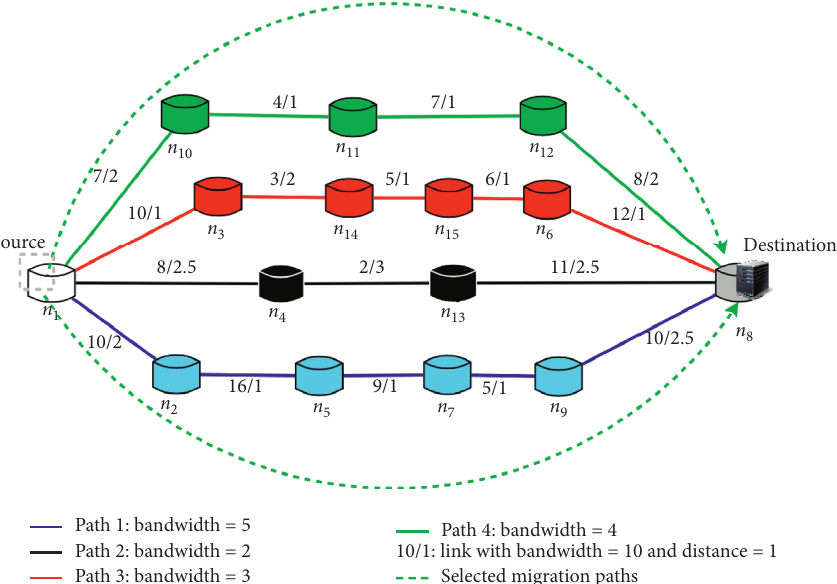
Figure 7: Best replacement path selection for paths with different